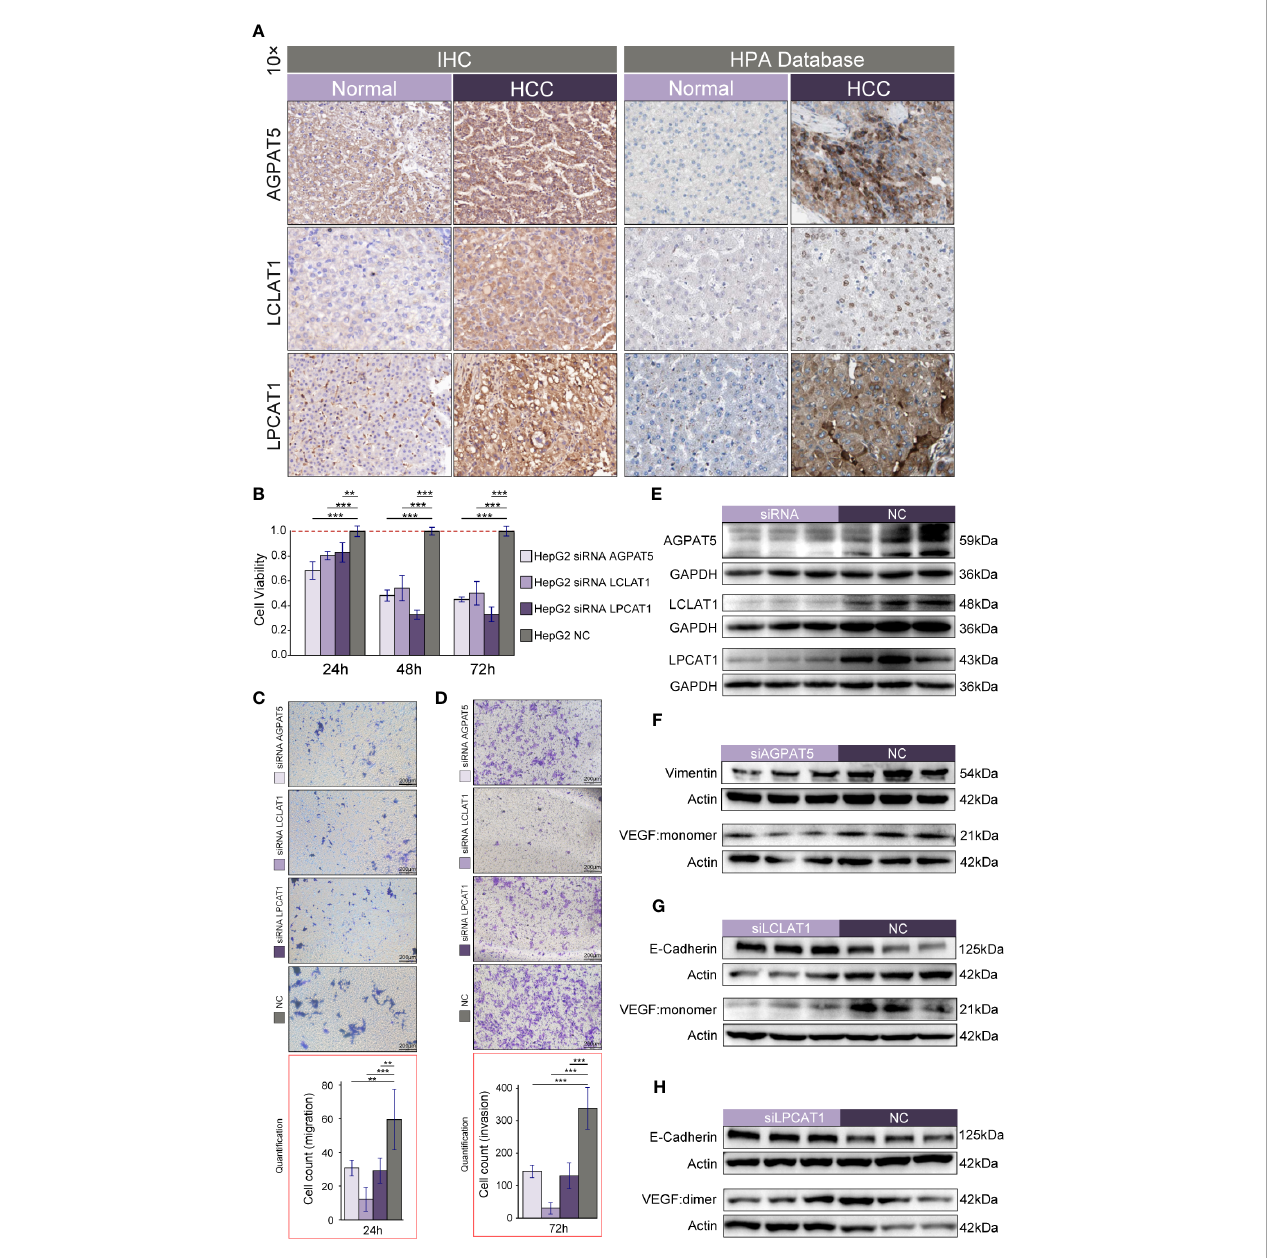
FIGURE 8 Preliminary validation of AGPAT5 , LCLAT1 , and LPCAT1 . (A) Immunohistochemistry of HCC tumor tissues and adjacent normal tissues. (B – D) CCK-8 assay (B) , migration assay (C) , and invasion assay (D) after knockdown of AGPAT5 , LCLAT1 , and LPCAT1 in HepG2 using siRNA and non-targeted control siRNA, respectively. (E) Western blotting validation of knockdown ef fi cacy after transfection of HepG2 using siRNA and non-targeting control siRNA. (F) Validation of common tumor-associated protein markers after knockdown of AGPAT5 . (G) Validation of common tumor-associated protein markers after knockdown of LCLAT1 . (H) Validation of common tumor-associated protein markers after knockdown of LPCAT1 . Representative images are shown. Magni fi cation 100x; scale bar: 200 m m. Signi fi cance signs: *p< 0.05; **p< 0.01; ***p<